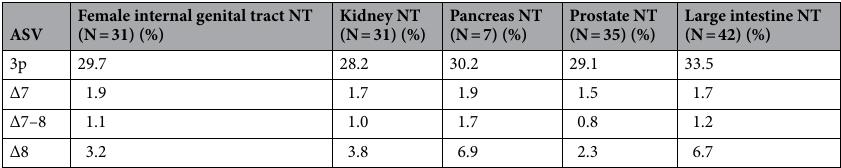
Table 1. The proportion of alternative splicing variants in selected non-tumour tissues. Each value represents the percentage of the overall HNF1B mRNA expression (100%; calculated as the sum of canonical exon 3 and 3p variants). N number of samples, NT non-tumour